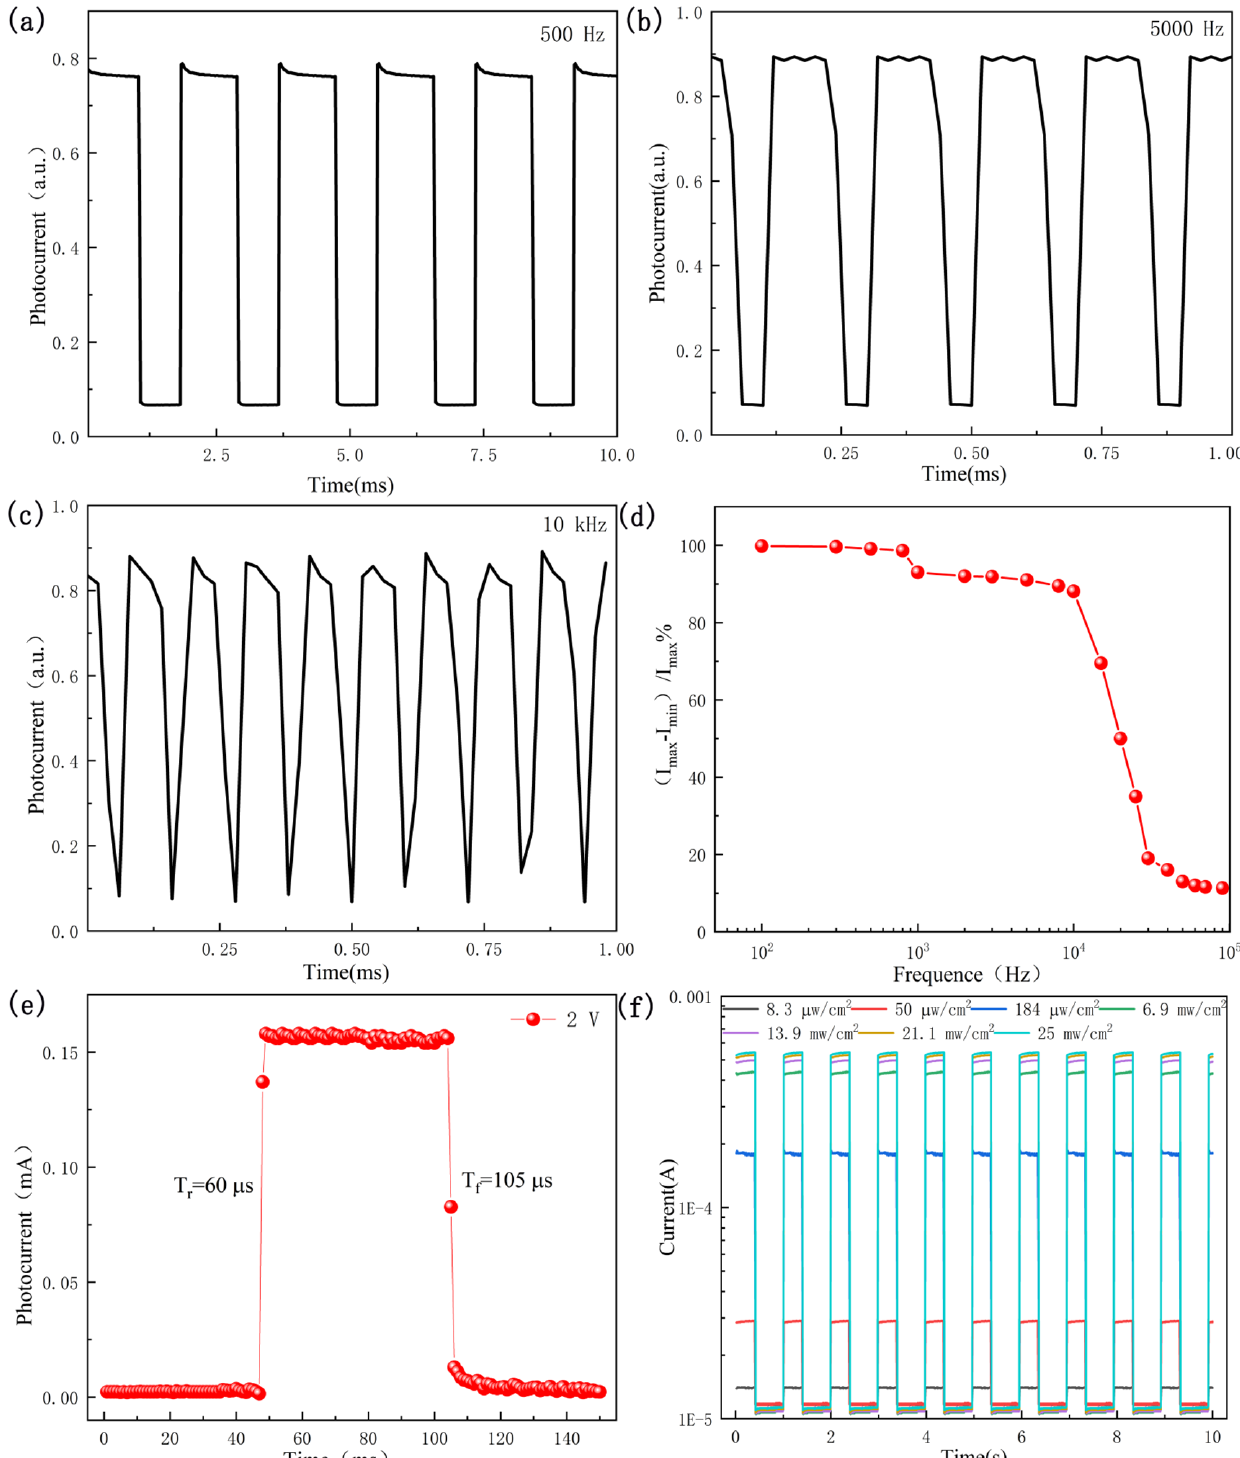
Figure 7. Photoresponse characteristics of the graphene/Si NTCAs heterojunction under pulsed light irradiation at frequencies of ( a ) 500 Hz, ( b ) 5000 Hz, and ( c ) 10 kHz at a voltage of 3 V. ( d ) Relative balance [(Imax-Imin)/Imax] vs. switching frequency. ( e ) Rising and falling edges for estimating rise time ( τ r) and fall time ( τ f). ( f ) Photoresponse of the graphene/Si NTCAs heterojunction under different light